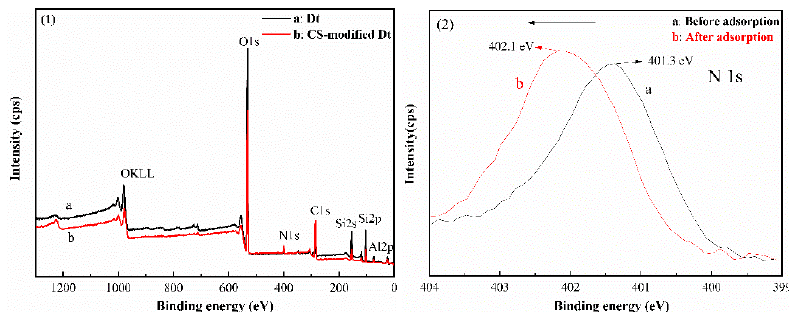
Figure 6. XPS spectra of (1)a Dt, (1)b CS-modified Dt, (2)a N1s energy before adsorption, and (2)b N1s energy after adsorption.